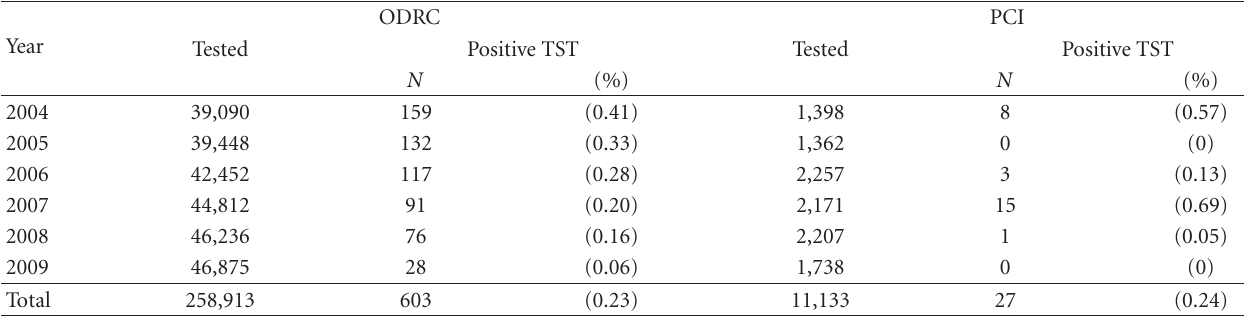
Table 1: Annual TB surveillance testing of incarcerated individuals, Ohio, 2004–2009 a